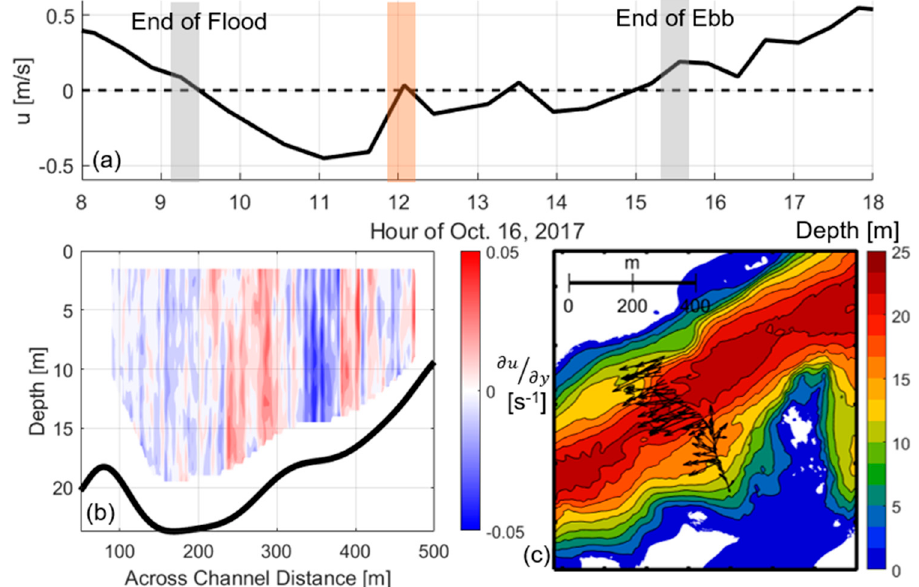
Figure 6. At station 2: ( a ) Depth-averaged along-channel velocity at station 2 over the tidal cycle. Grey boxes indicate the end of each tidal phase and the orange box indicates the time of a transect during maximum ebb, shown in ( b , c ). ( b ) (cid:2034)(cid:1873) (cid:2034)(cid:1877)(cid:3415) varying across channel ( x -axis) with depth ( y -axis) and ( c ) depth averaged current vectors over bathymetry for the transect noted. (cid:2034)(cid:1873) (cid:2034)(cid:1877)(cid:3415) was smoothed over two depth bins (1 m) and six across-channel bins (12 m) to highlight broad trends.